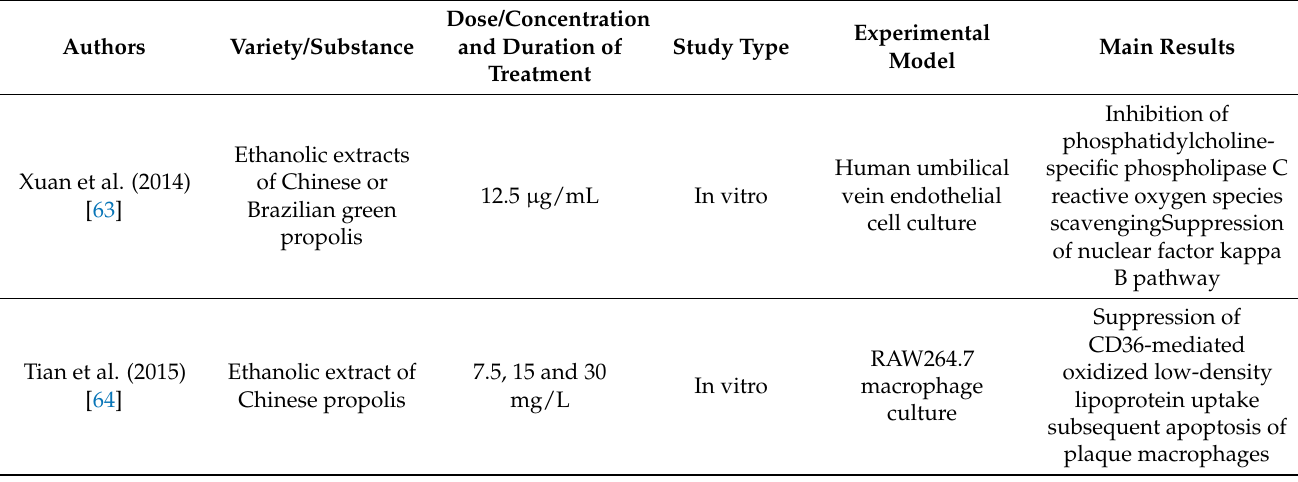
Table 2. Description and main results of the most relevant studies assessing the anti-atherosclerotic activity of propolis.